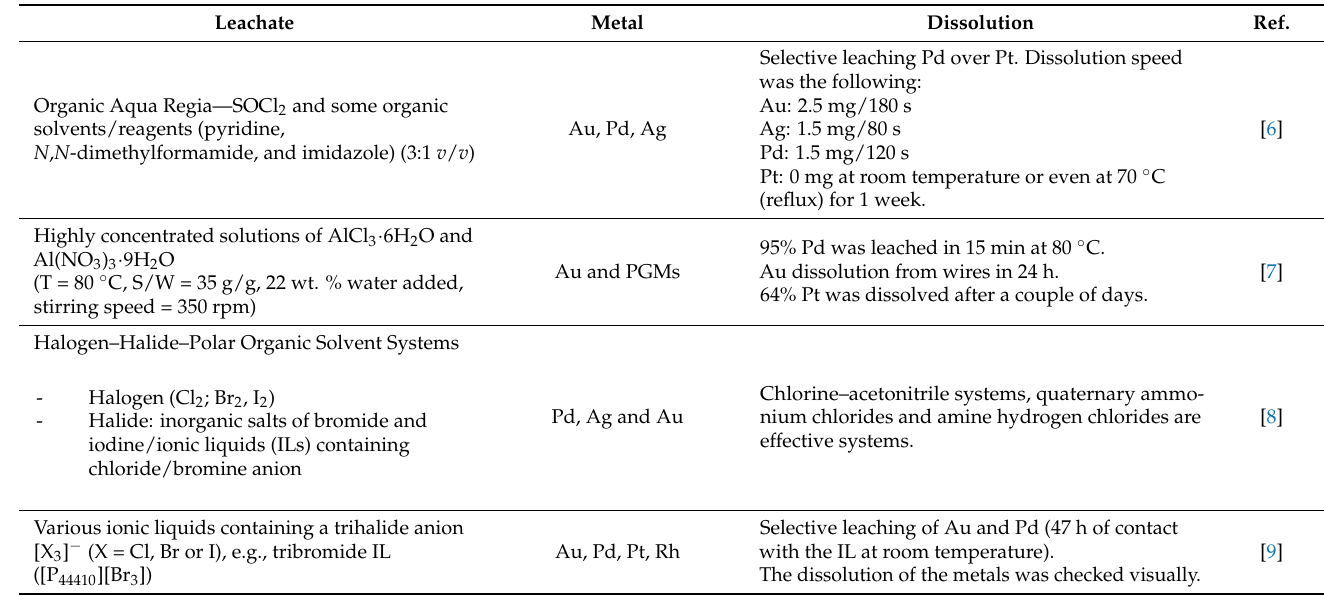
Table 1. Leaching of platinum group metals (PGMs) by using non-aqueous